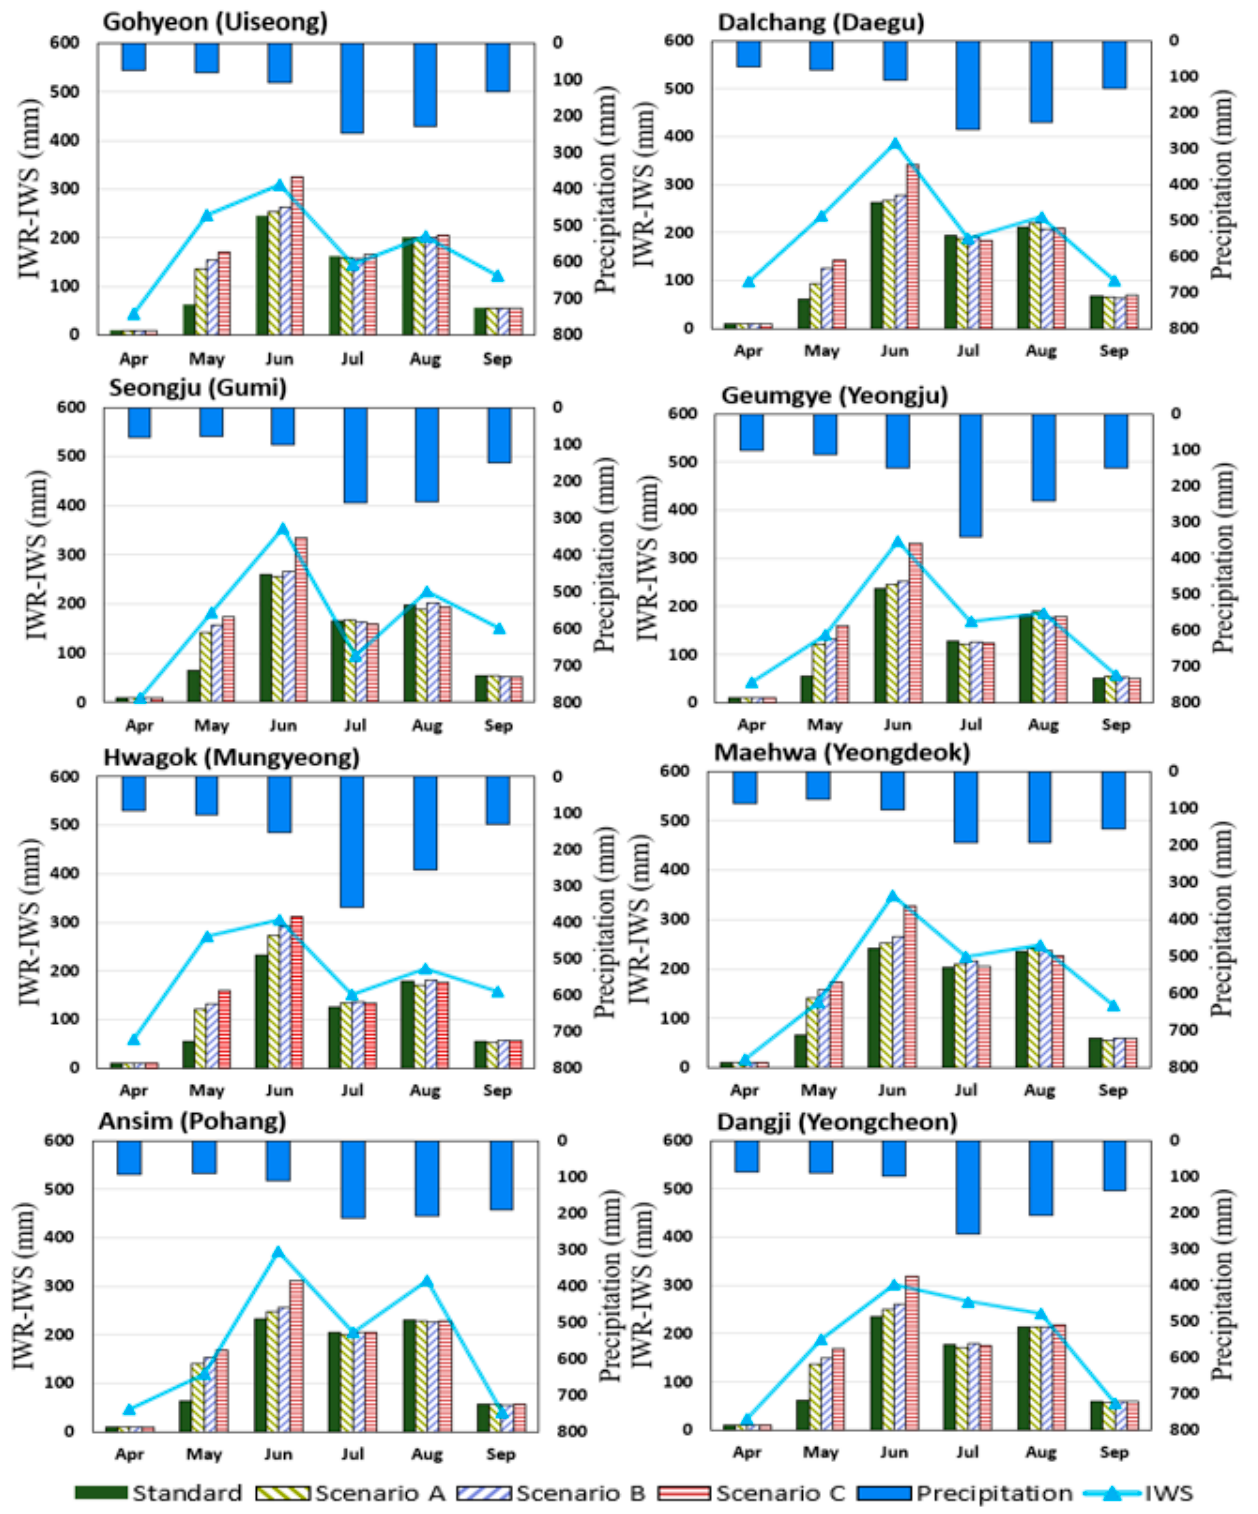
Figure 5. Comparisons of monthly precipitation (P), irrigation water requirement (IWR), and irrigation water supply (IWS) for transplanting scenarios. Description of the transplanting scenarios is provided in Table 2.